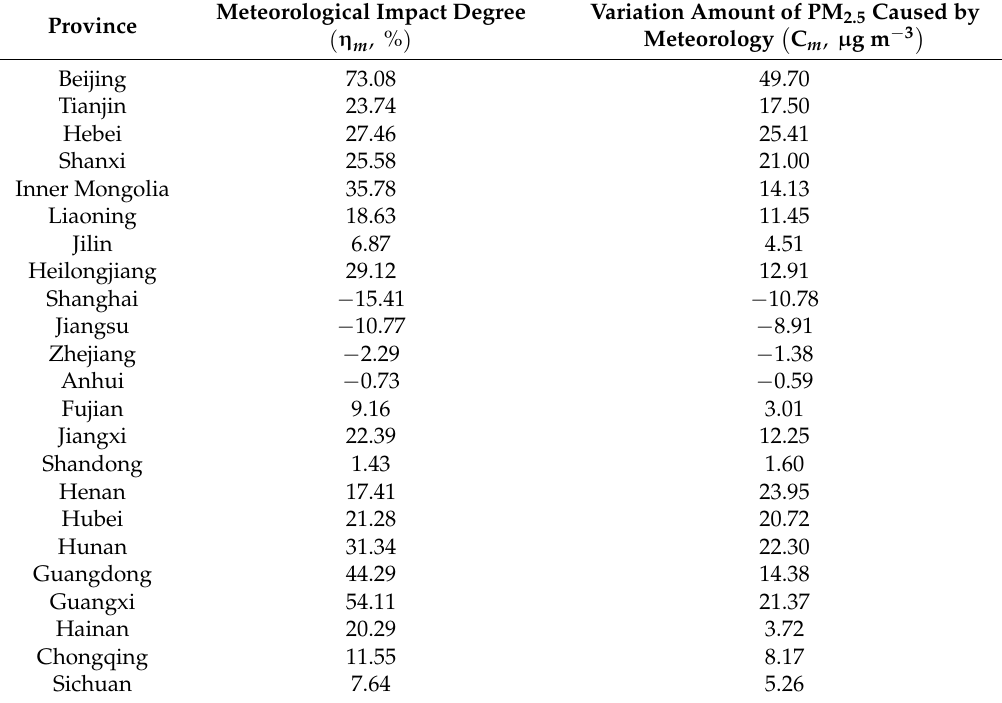
Table 6. Impacts of the meteorological conditions on the PM 2.5 pollution in each